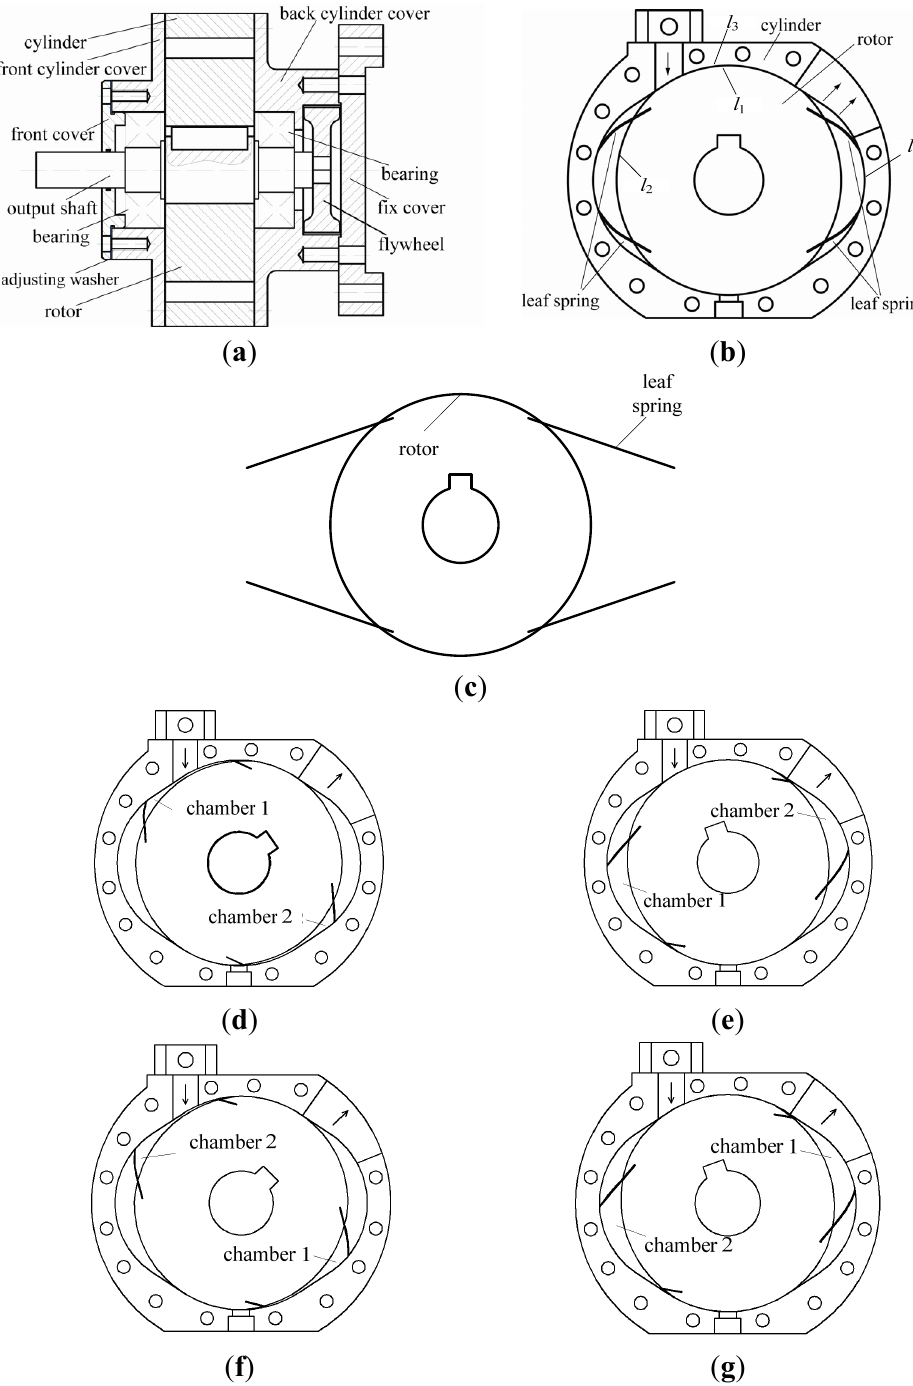
Figure 1. ( a ) Sketch of leaf spring rotary engine; ( b ) sketch of the rotor–spring–cylinder assembly; ( c ) sketch of the rotor; ( d ) intake procession of the engine; ( e ) compression procession of the engine; ( f ) combustion procession of the engine; and ( g ) exhaust procession of the